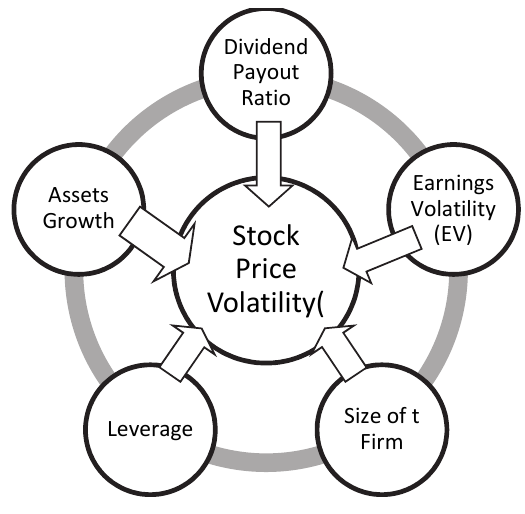
Fig. 1. The structure of the proposed